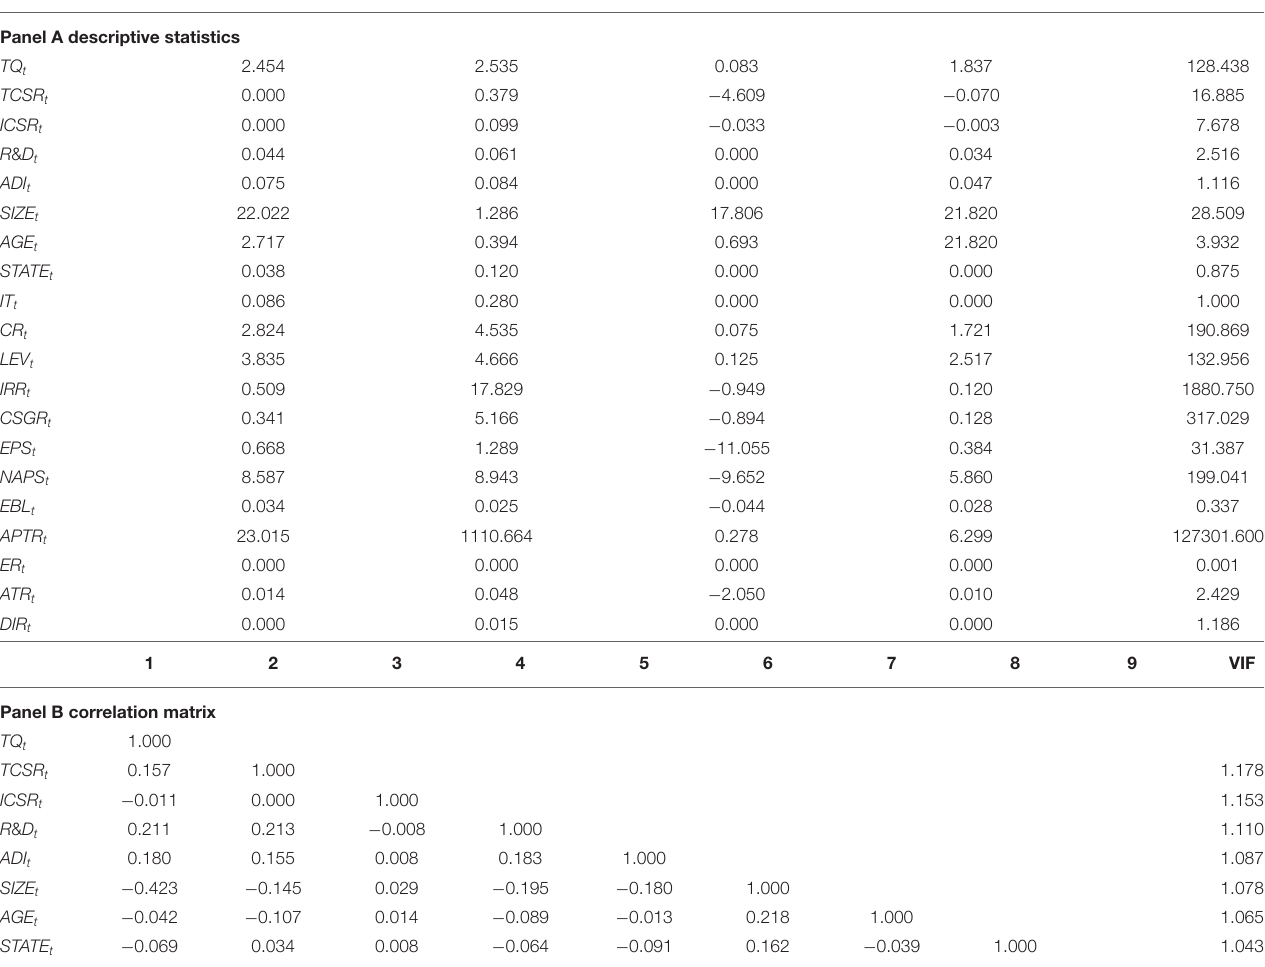
TABLE 2 | Descriptive statistics, correlation matrix, and VIF analysis.